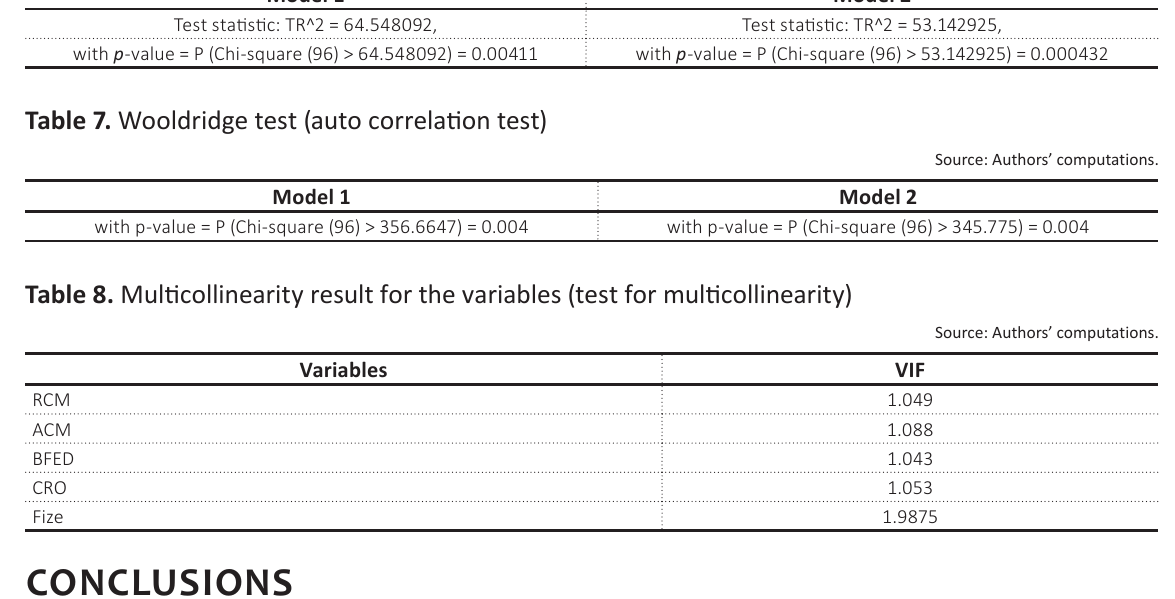
Table 6. Breusch-Pagan/Cook-Weisberg test Model 1 Model 2